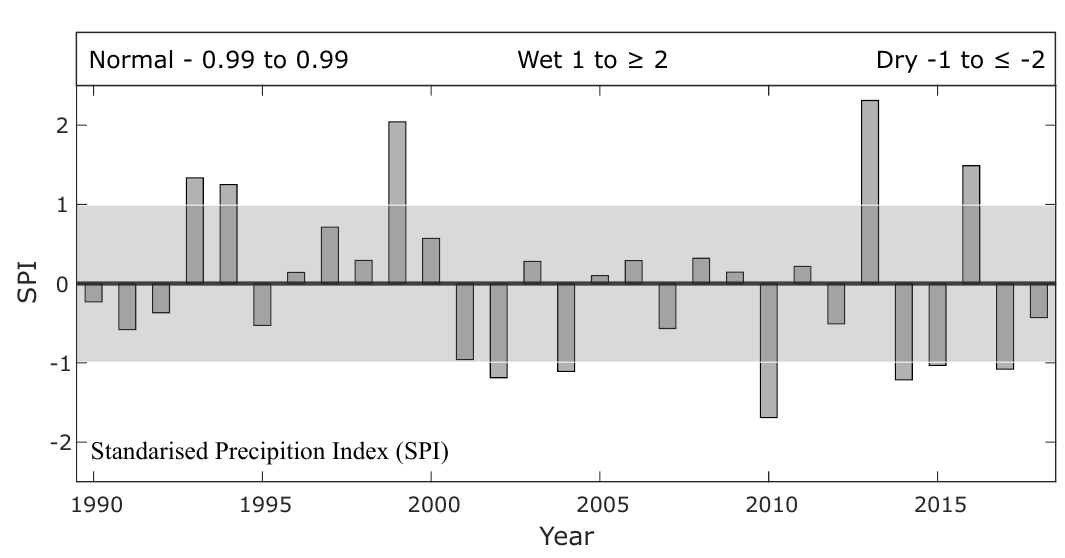
Figure 2. Areal averaged Standardized precipitation Index (SPI) for Indian summer monsoon (June, July, August, September) from 1990 to 2018. Shaded region (SPI − 0.99 to 0.99) shows the normal precipitation condition. SPI in range ( − 1 ≤ − 2 ) and (1 ≥ 2) suggests drought and wet condition